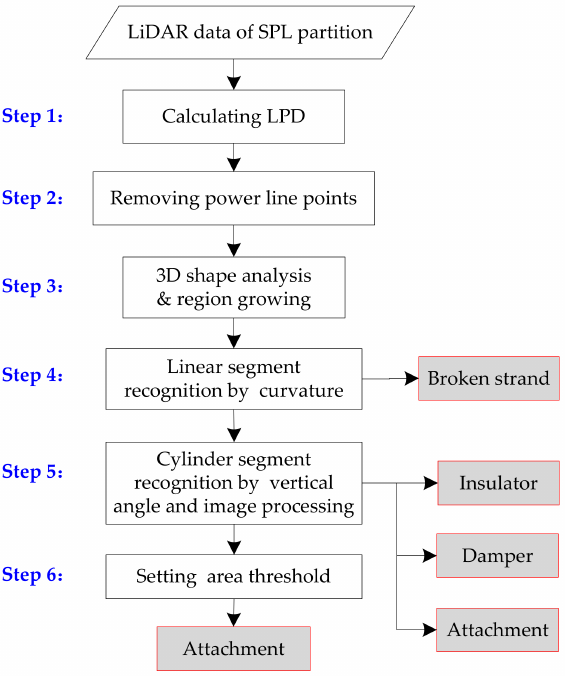
Figure 6. Flowchart of SPL partition